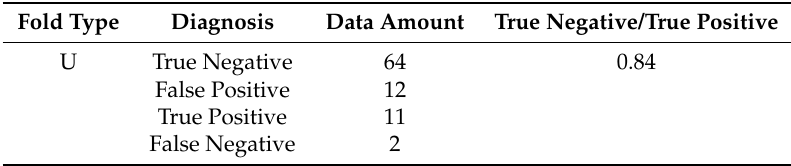
Table 4. Performance of the proposed method from medical perspective.